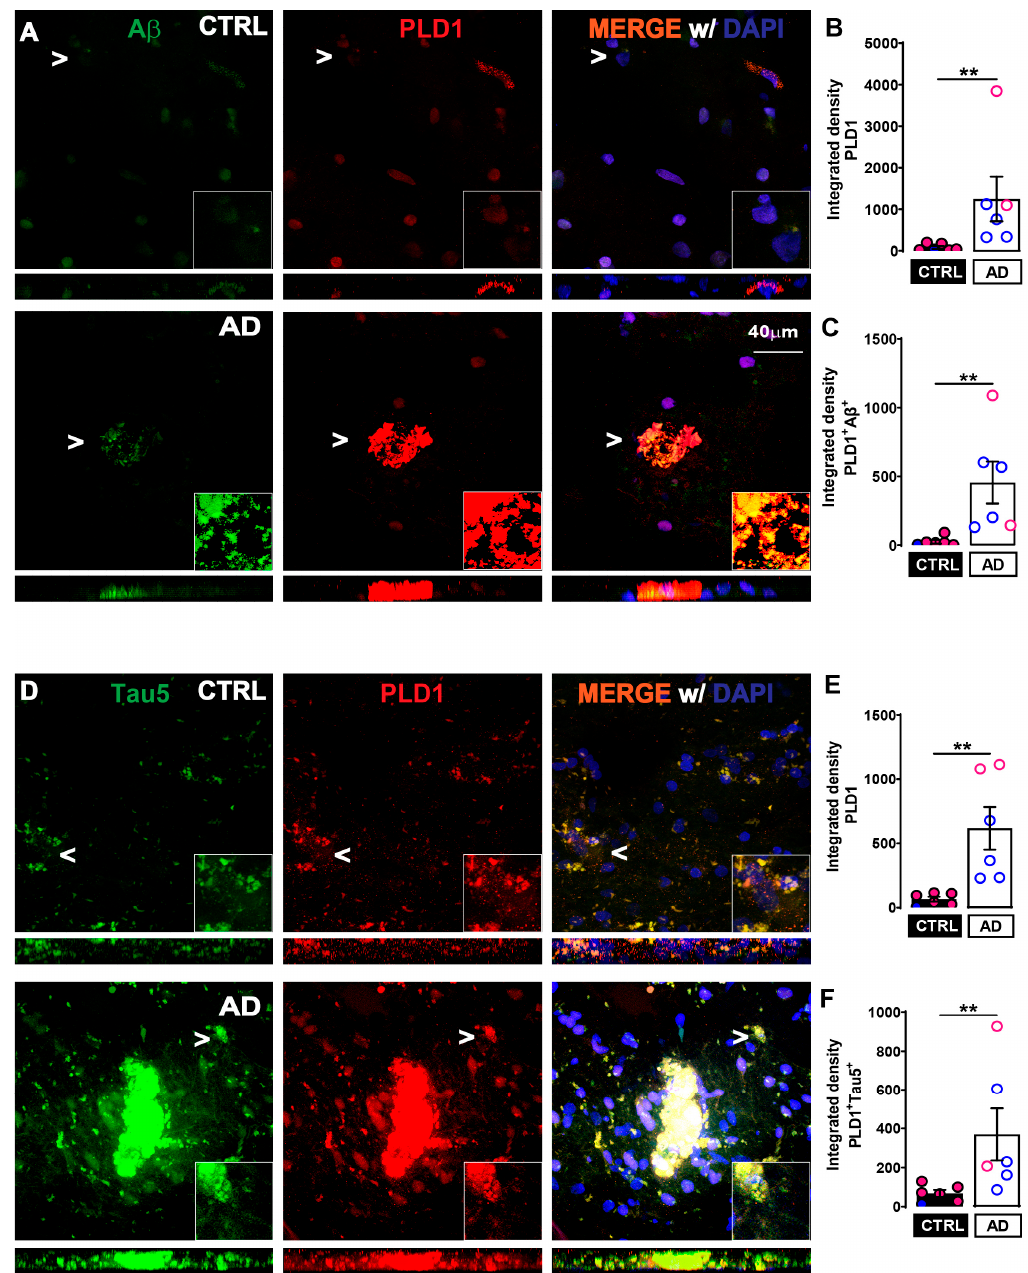
Figure 1. Increased co-staining of PLD1 and A β or tau in post-mortem AD hippocampi compared to CTRL. ( A ) Double immunofluorescence showing higher levels of PLD1 (red) with A β (green) in AD samples compared to age-matched controls. ( B ) Increased PLD1 expression in AD (** p = 0.0022). ( C ) Significantly increased co-localization of PLD1 and A β in AD (** p = 0.0022). ( D ) Double im- munofluorescence showing higher levels of PLD1 (red) with tau (green) in AD samples compared to age-matched controls. ( E ) Increased PLD1 expression in AD observed with PLD1-tau5 co-staining (** p = 0.0022). ( F ) Significantly increased co-localization of PLD1 and tau in AD (** p = 0.0260). Merge (yellow) is shown with DAPI staining of nuclei in the representative panels. White arrowheads denote the region that is zoomed at the lower right-hand corner to better demonstrate the interaction. At the bottom of each square panel, a rectangular panel of the confocal stacks shows the qualitative distribution and co-localization. Values are expressed as mean ± SEM. n = 6 subjects per group. Unpaired non-parametric Mann–Whitney test. Scale bar = 40 µ m. Each circle in the graph represents a single subject. Red/pink circles indicate females while blue circles indicate